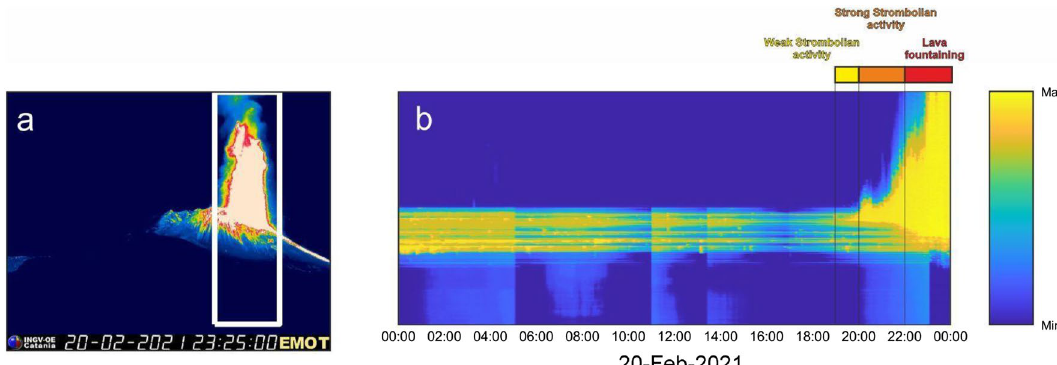
Figure 5. Thermal imagery of lava fountaining. ( a ) Image taken by EMOT thermal camera at 23:25 on 20 February 2021 shows lava fountaining at SEC. ( b ) Time/height diagram shows the time evolution of the maximum temperature as a function of height for the area enclosed by the white rectangle in ( a ). An animation derived from EMOT thermal imagery video and integrated with infrasonic signal is provided in Supplementary Materials (Supplementary Video